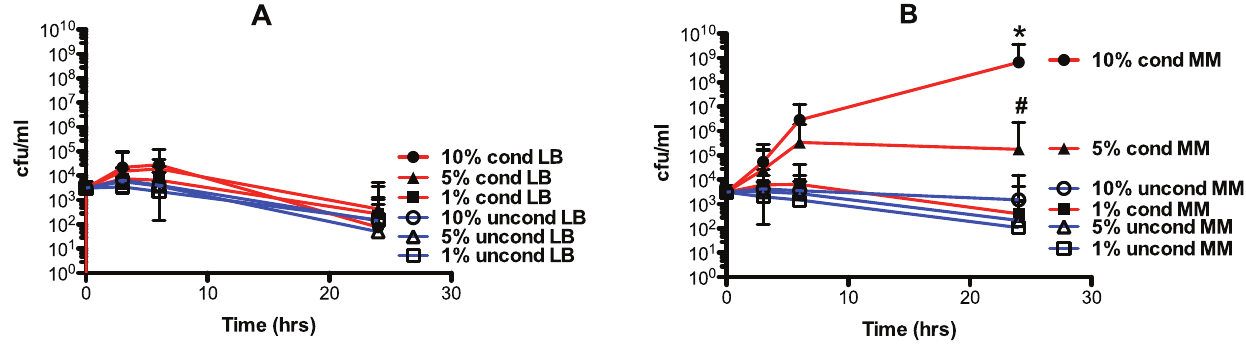
Figure 3. Growth/survival of hvKP1 grown in human ascites supplemented with hvKP1 generated M9 and LB conditioned media. The growth of hvKP1 was assessed at 0, 3, 6, and 24 hours in human ascites (batch 2) supplemented with unconditioned (uncond) or hvKP1 generated conditioned (cond) rich laboratory (LB) or minimal (M9) media resulting in final concentrations of 0%, 1%, 5%, and 10%. Panel A: ascites supplemented with conditioned rich laboratory medium (LB). Panel B: ascites supplemented with conditioned minimal medium (MM). Supplementation with 10% conditioned MM compared to 0% resulted in a significant increase in growth/survival (* P , 0.05/3) and supplementation with 5% conditioned MM compared to 0% resulted in a trend towards an increase in growth/survival ( # P . 0.05/3 and , 0.05). Data are Mean 6 S.E.M.; N=2.